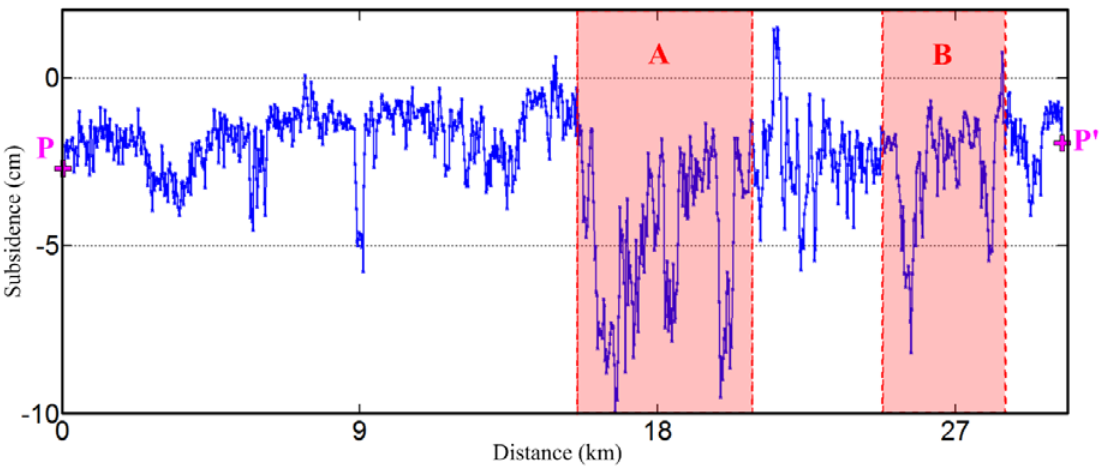
Figure 8. Subsidence profile along the highway, from point P to point P’ in Figure 5.